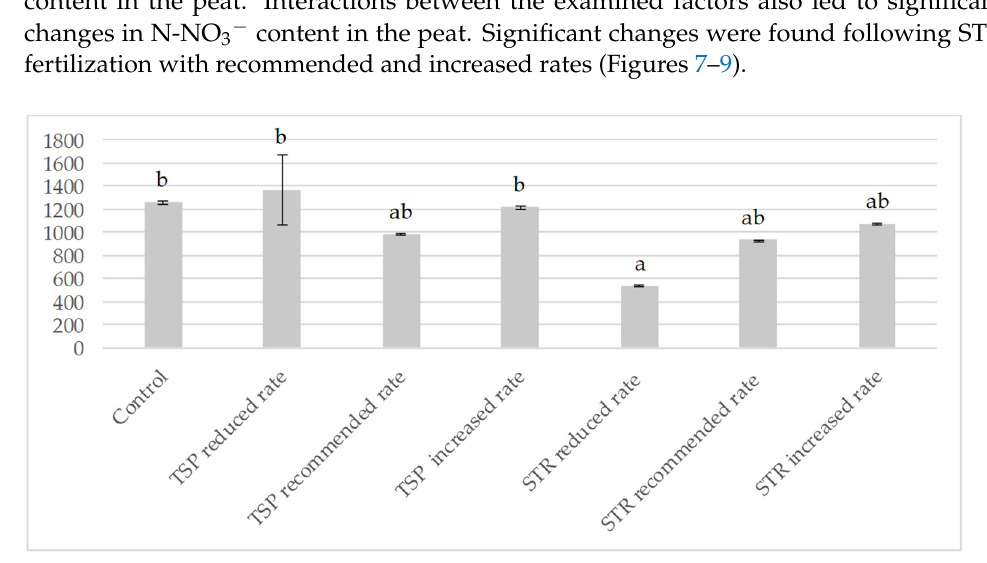
Figure 8. Phosphorus content in the peat (mg dm − 3 ) as affected by the interaction of examined factors (A × B) at the level of significance α = 0.05 ( p value < 0.01). Figure 9. Nitrate nitrogen ( content in the peat (mg dm − 3 ) as affected by the interaction of examined factors (A × B) at the level of significance α = 0.05 ( p value < 0.001).